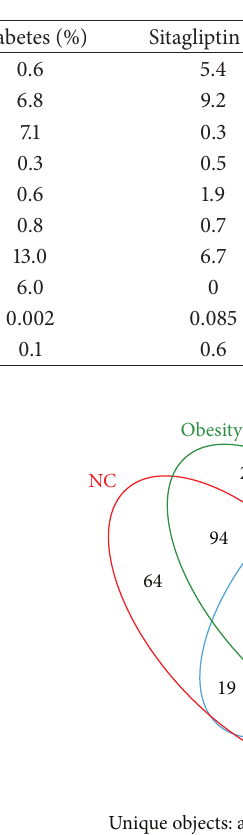
Table 2: Statistical analysis was performed by Wilcoxon Signed-Rank test. Data of normal, obesity, diabetes, and sitagliptin are relative abundance (percentage) of all sequences in each group ( 𝑃 # group obesity versus normal; 𝑃 ∗ group diabetes versus obesity; 𝑃 󳵻 group diabetes versus sitagliptin).